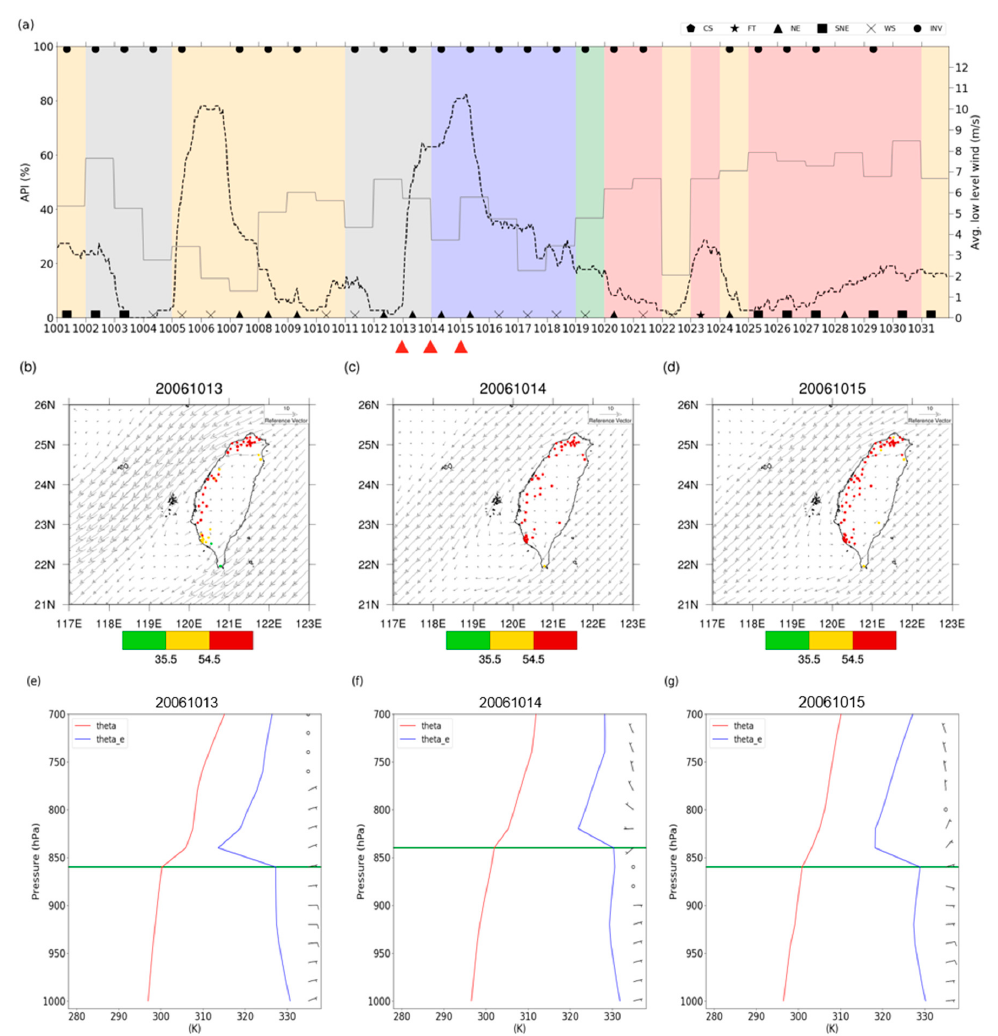
Figure 6. The case study for October 2006. ( a ) API time series (dashed line), the low-level wind speed averaged over the surface to 925 hPa (thin line), the near-surface temperature inversion around